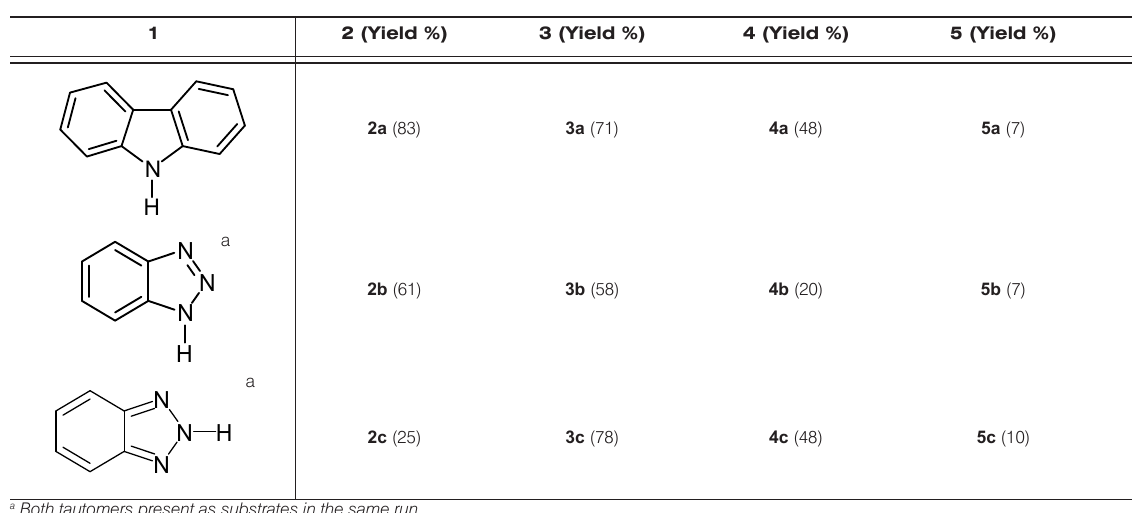
Table 1. Yields of intermediates and final products from Scheme